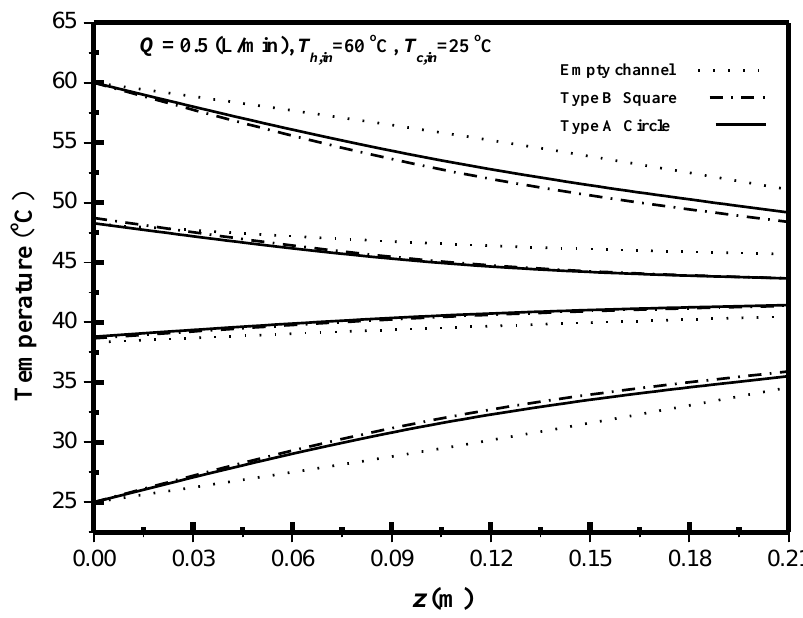
Figure 9. Effect of geometric turbulence promoters on temperature profiles.